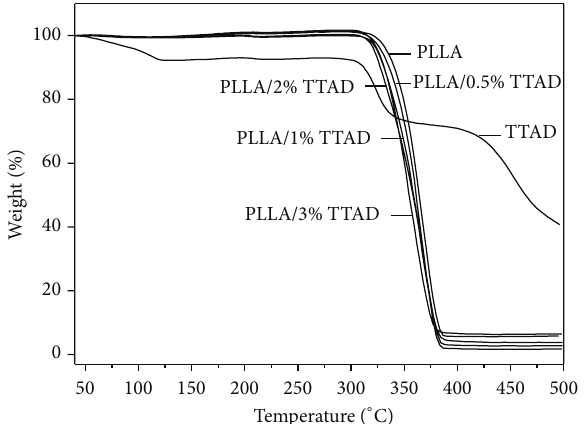
Figure 10: TGA curves of thermal degradation for PLLA and PLLA/TTAD